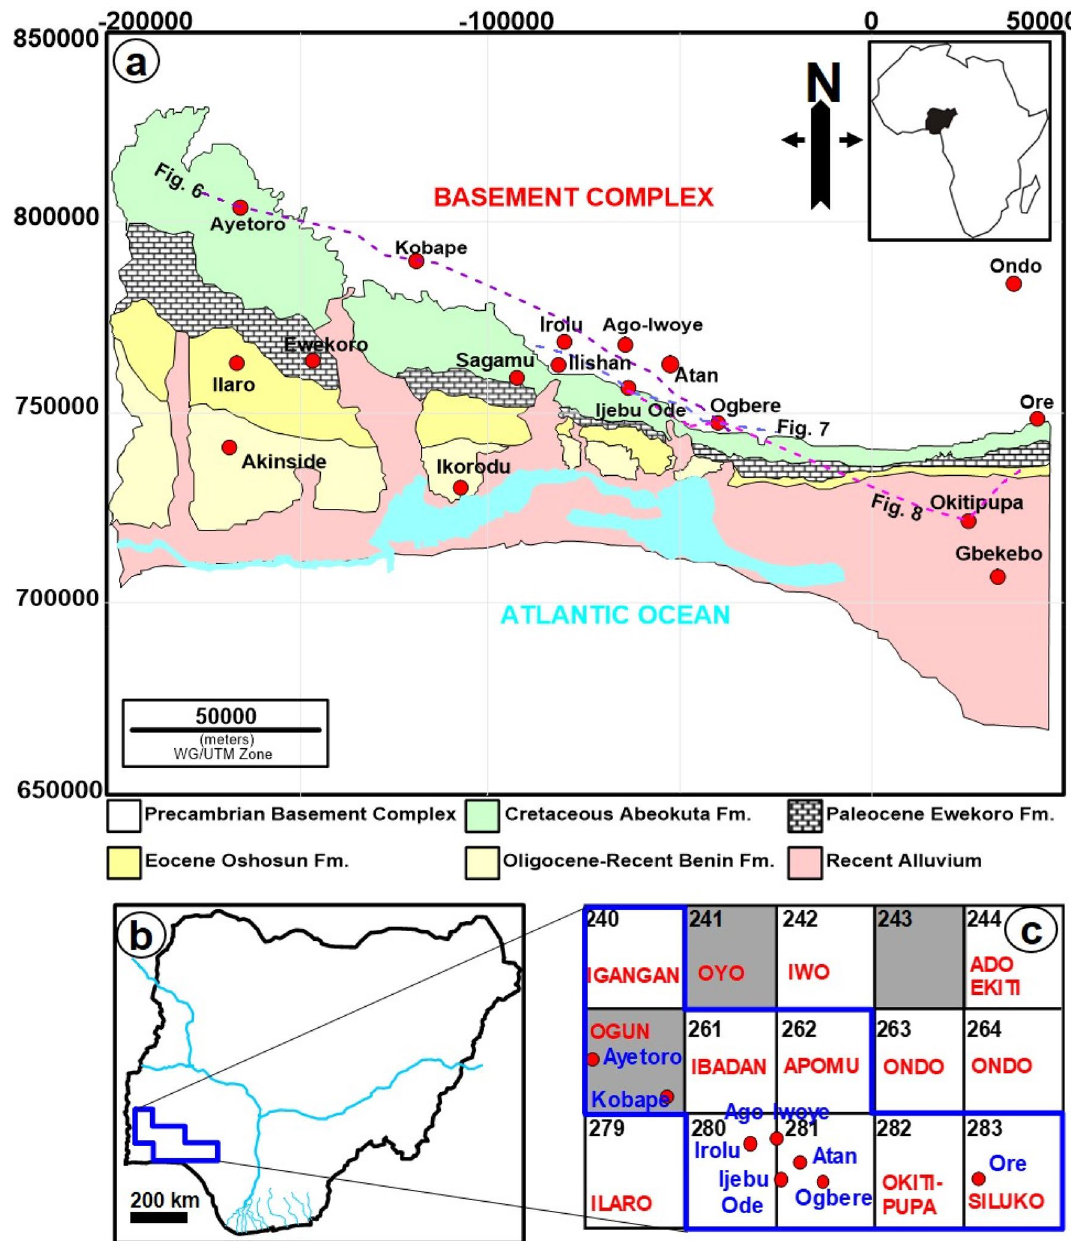
Figure 1. ( a ) Geologic and location map of the study area showing the major localities discussed in the text and also the VES section lines in Figs. 6, 7 and 8. Inset map shows location of Nigeria within the context of Africa . ( b ) Map of Nigeria showing the location of the aeromagnetic grids (blue polygon) used in this study. ( c ) These are 240-Igangan, 260-Ogun, 261-Ibadan, 280-Lagos, 262-Apomu, 281-Lekki, 282-Okitipupa, and 283-Siluko. Note: ( a ) and ( b ) were drawn in by CorelDRAW2016, https ://www.corel